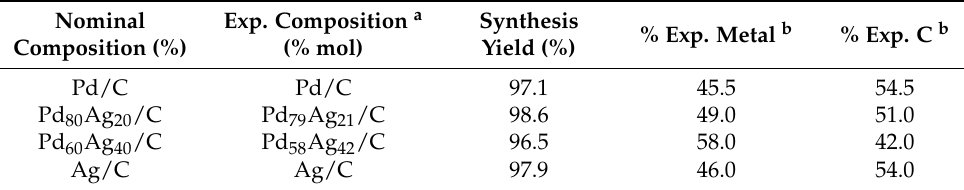
Figure 2 . Thermogravimetric profiles of the electrocatalysts 40% metals-based/C—temperature range of 273–1200 K ( a ) TG ( b ) DTG. Table 3. The experimental composition was obtained by EDX, reaction yield, and thermogravimetry data for the electrocatalysts.